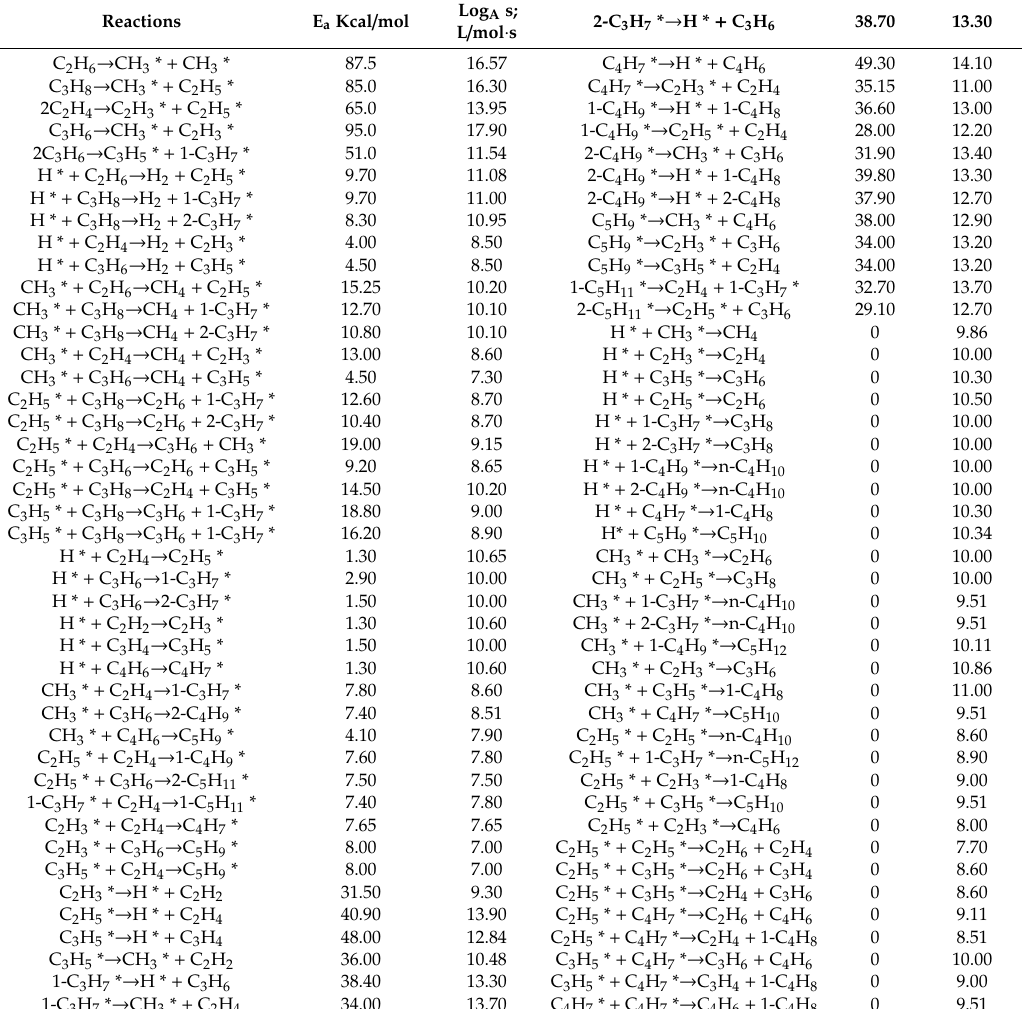
Table 2. Free-radical network and its parameters [49].